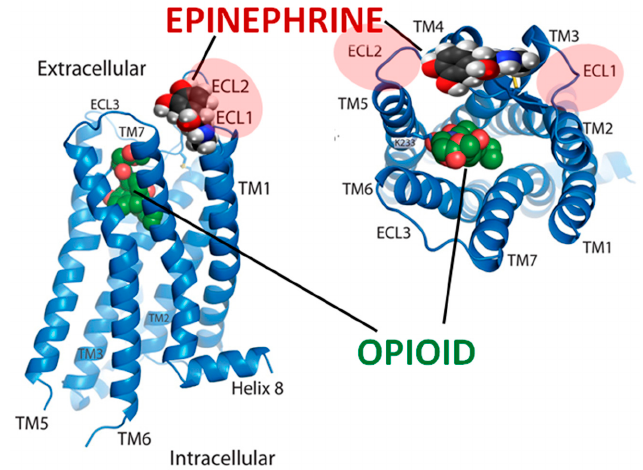
Figure 21. Model for epinephrine binding to the mu opioid receptor, adapted and modified from [85]. The data illustrated in Figures 4–8 suggest that adrenergic agonists, but not antagonists or most other compounds (Table 2), bind to portions of both the first extracellular loop (ECL1) and the second extracellular loop (ECL2) but not transmembrane (TM) regions. Opioids also bind to the same extracellular loops suggesting that these loops act as semi-specific attractors for both ligands and enhancers of receptor activity.